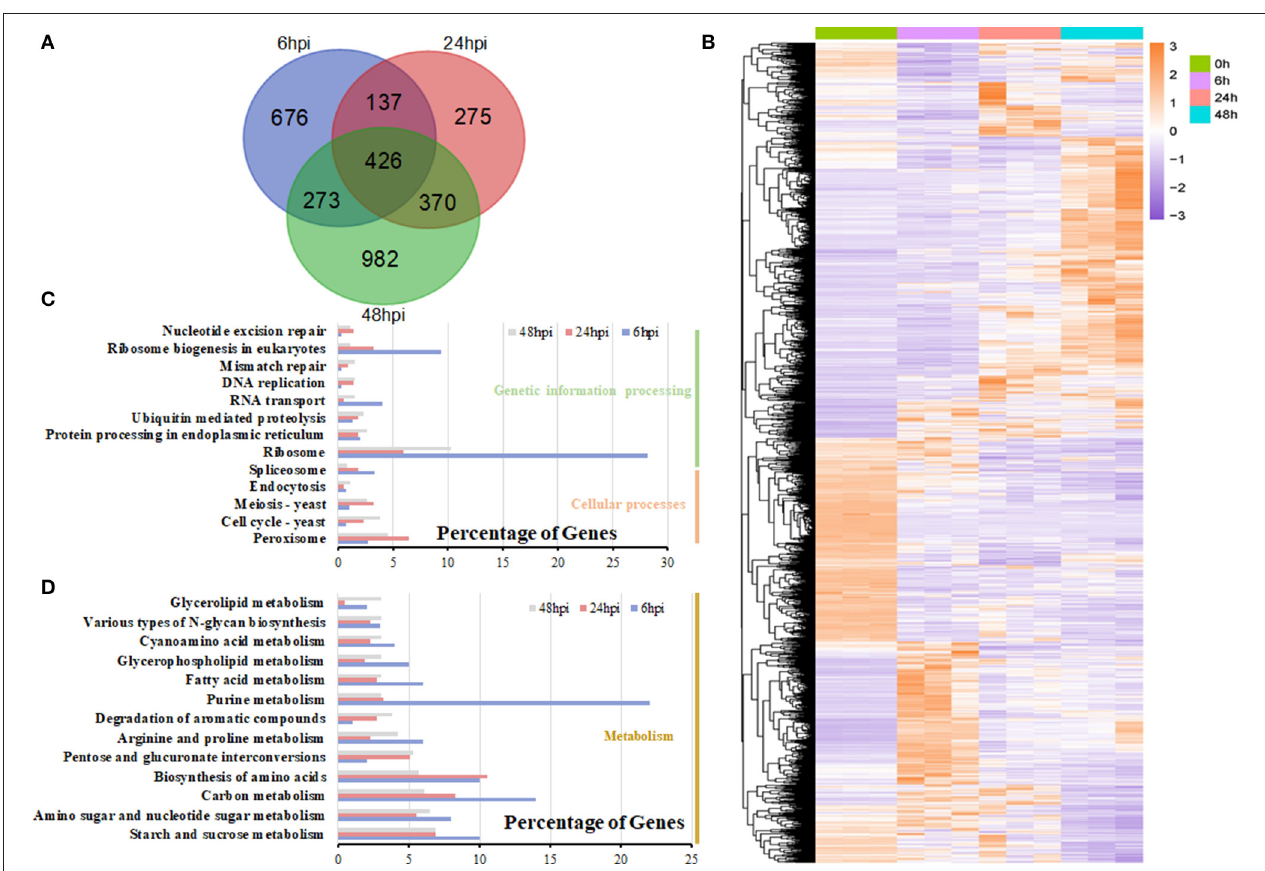
FIGURE 6 | DEG analysis in S. sclerotiorum . (A) The number of DEGs expressed at the 6-, 24-, and 48-hpi stages and their overlapping. (B) Heatmap illustrating the hierarchical clustering results for RNA-seq. (C,D) KEGG enrichment analysis of DEGs at the 6-, 24-, and 48-hpi stages. The x-axis indicated the ratio of the enriched gene number to the total gene number at three stages, and the y-axis indicated different enriched